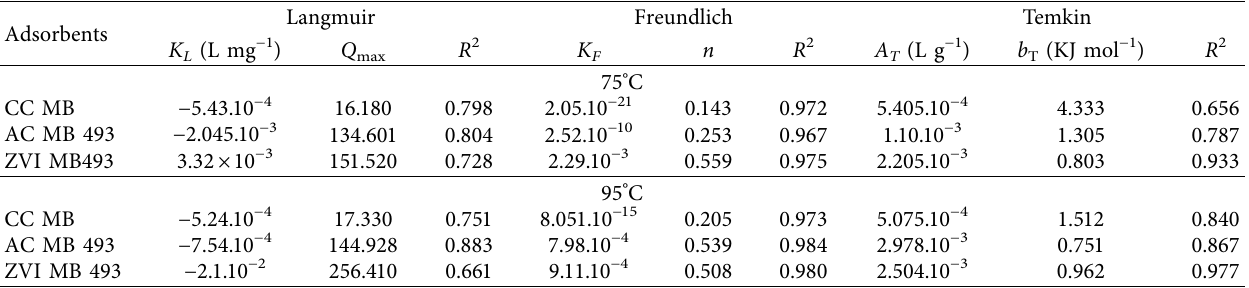
Table 3: Comparative adsorption capacity Q